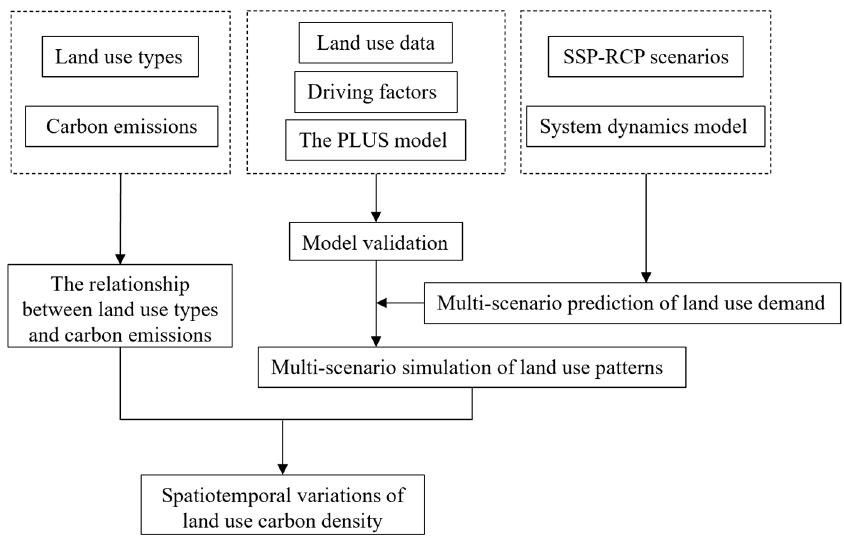
Figure 1. Technical